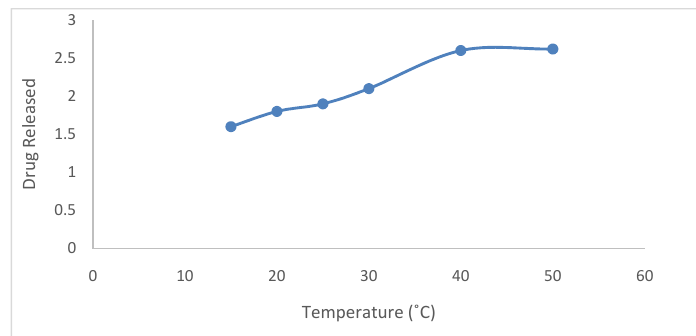
Fig. 5. Impact of temperature on releasing of ceftriaxone by Fe